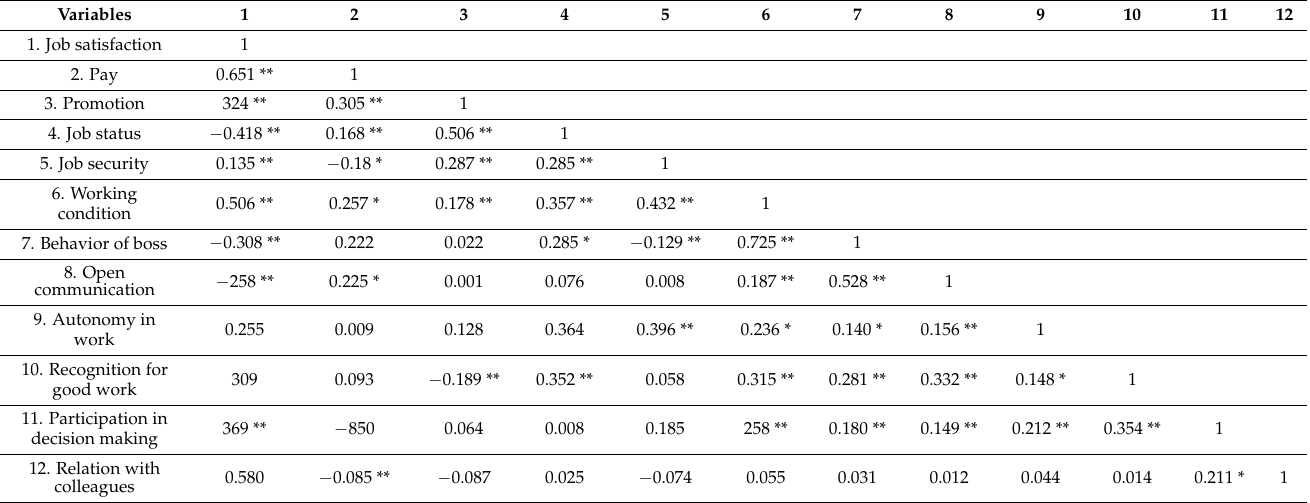
Table 11. Correlation matrix among dependent (job satisfaction) and independent (professional aspects of job) variables (N = 300).